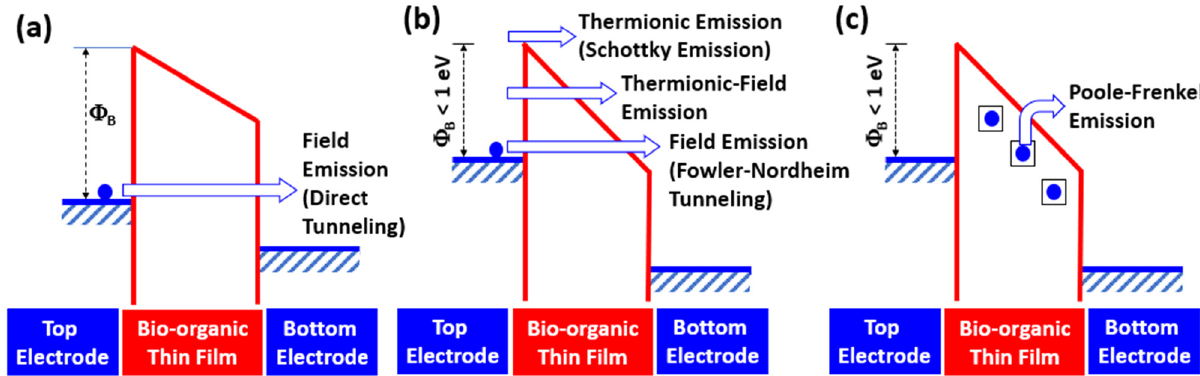
Figure 6: Schematic of the proposed electrode - limited carrier conduction mechanisms of ( a ) direct tunneling, ( b ) Fowler – Nordheim tunneling, thermionic - fi eld emission, and Schottky emission, and ( c ) bulk - limited carrier conduction of Poole – Frenkel emission of the bio - organic - based RRAM with energy barrier height ( Φ B ) between the top electrode and LUMO of the bio - organic thin fi lm. and represent electron and trap,